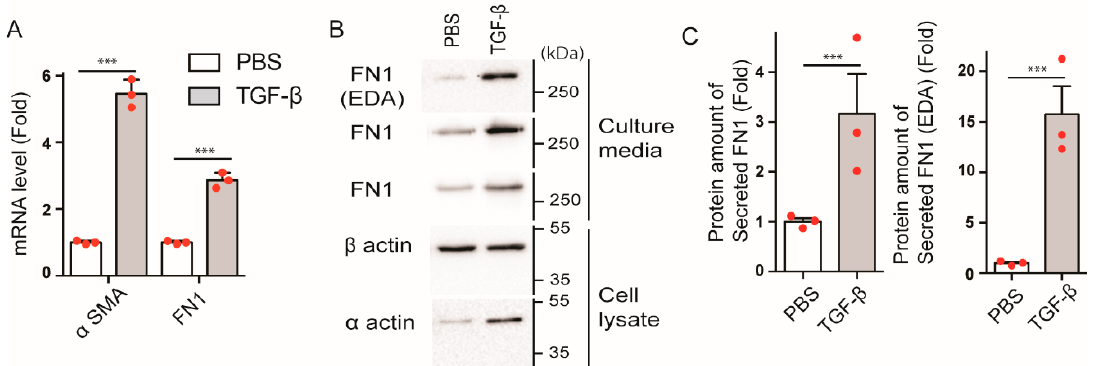
Figure 2. Effect of TGF- β on FN1 expression and secretion from HPMCs. ( A ) mRNA levels of FN1 in HPMCs were determined by q-PCR analysis. The cells were serum-starved for 8 h and treated with PBS or TGF- β (5 ng/mL) for 48 h. Expression levels were normalized to the control (PBS). n = 3. *** p < 0.001 vs. PBS. ( B ) Representative Western blot. Full-length blots were presented in Supplementary Figure S1. ( C ) Statistical representation of Western blot analysis. n = 3, *** p < 0.001 vs. PBS. FN1 protein expression levels were analyzed by Western blotting in both cell lysate and culture medium. Culture media were changed at 48 h after TGF- β stimulation and the culture media for Western blotting were collected after 24 h. Cell lysate were prepared after the collection of the culture medium. The red spots in bar graphs display the distribution of data points.